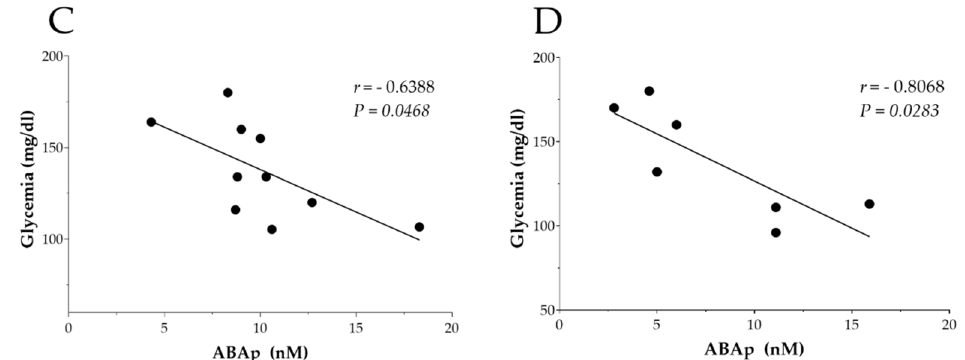
Figure 2. Correlation analysis data. Pearson correlation analysis was performed to evaluate the link between plasmatic ABA levels and glycemia in the following groups: ( A ) low-dose TN group (500 mg of TN three times/day) at baseline (T0), ( B ) low-dose TN group (500 mg of TN three times/day) after 90 days (T90), ( C ) high-dose TN group (750 mg of TN three times/day) at baseline (T0), and ( D ) high-dose TN group (750 mg of TN three times/day) after 90 days (T90). Abbreviations: ABA, abscisic acid; TN, thinned nectarines.